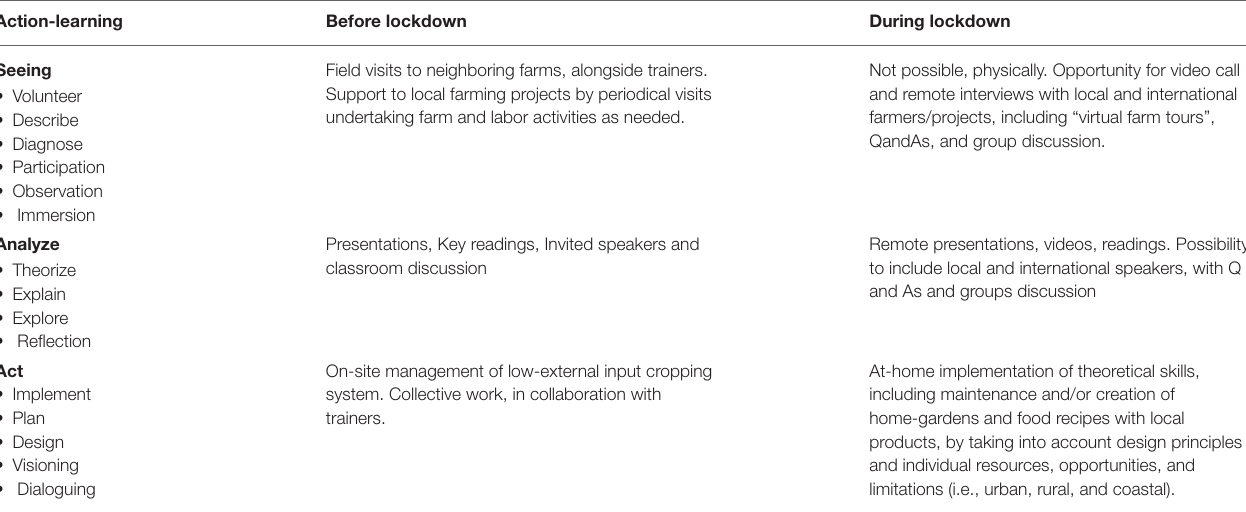
TABLE 2 | Changes and opportunities to participatory action-learning strategies before and during lockdown and self-isolation due to COVID-19, based on authors’ fieldwork and facilitation experience. Action-learning Before lockdown During lockdown